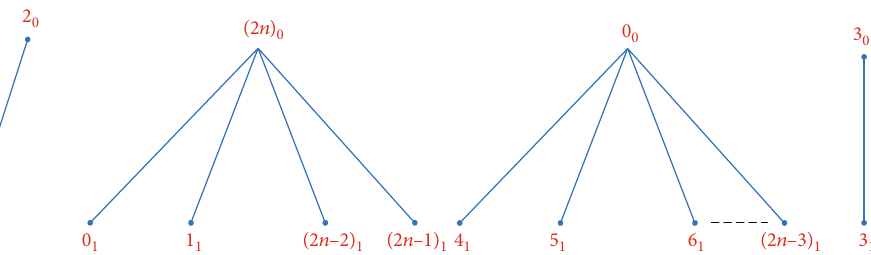
∪ K ∪ K ∪ K . 1,1 1,2 1,4 1,2 n ‐ 6